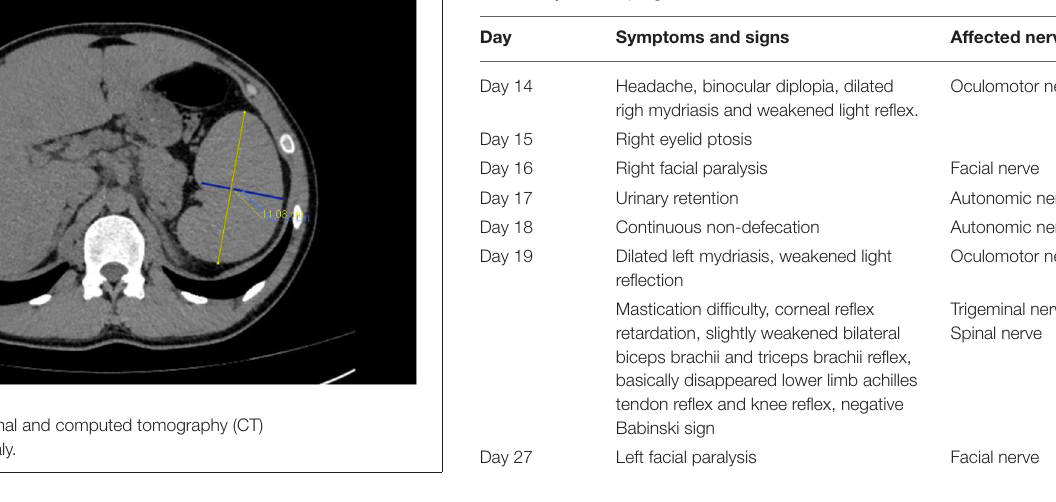
TABLE 1 | Disease progression